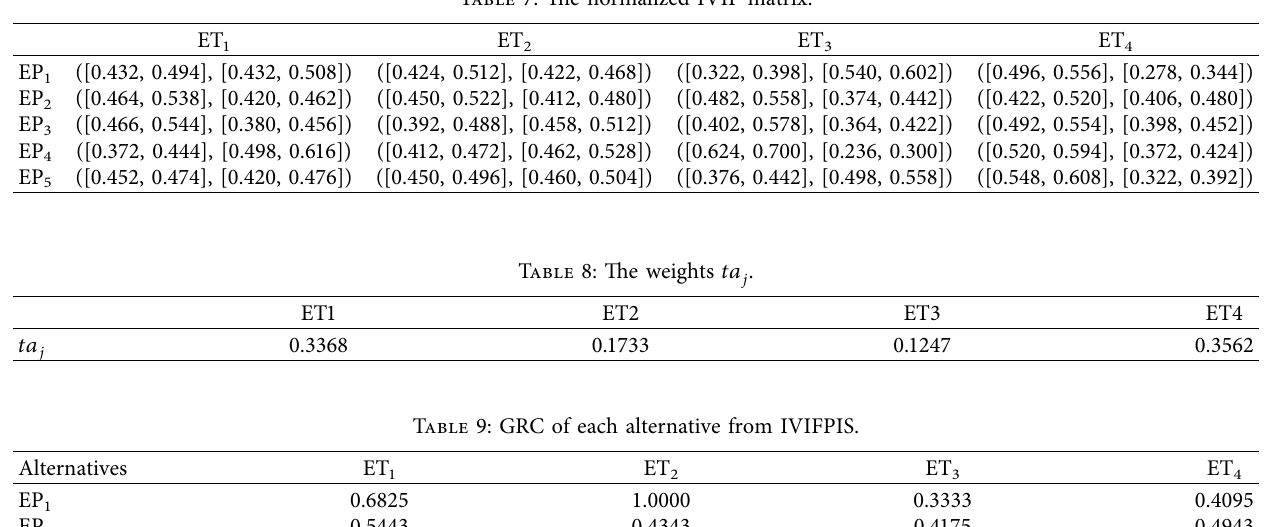
Table 7: The normalized IVIF matrix.